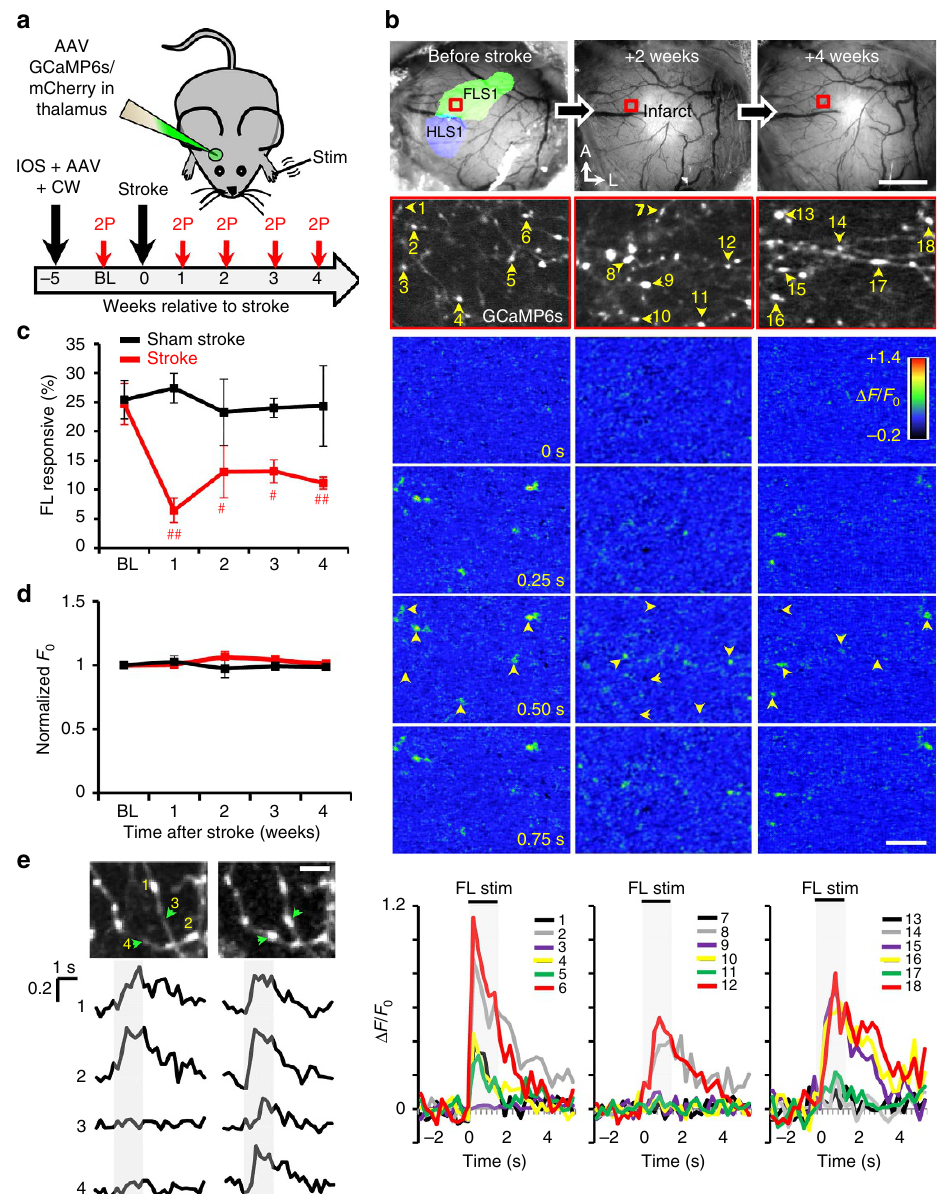
Figure 2 | Thalamocortical axons are less responsive to forelimb stimulation after stroke. ( a ) Graphical summary of GCaMP6s imaging experiments. ( b ) Top, bright-field images of the cortical surface before and after stroke (top row). IOS imaging was used to delineate the functional representation of the FLS1 and primary hindlimb somatosensory cortex. Below; images showing GCaMP6s-expressing thalamocortical boutons (numbered 1–18) within boxed regions. Colour montages below show forelimb-evoked changes in GCaMP6s fluorescence ( D F / F 0 ) for axonal boutons imaged before stroke and 2–4 weeks later. Plots show calcium responses to forelimb stimulation ( D F / F 0 ) within individual boutons at each time point. ( c ) Graph shows the percentage of forelimb responsive thalamocortical boutons plotted as a function of time after stroke (2,825 boutons were analysed in 6 stroke mice) or sham (1,706 boutons analysed in 4 mice) procedure. ( d ) Normalized GCaMP6s fluorescence ( F 0 ) in axonal boutons over time. ( e ) Top, images show mCherry-labelled thalamocortical boutons (numbered 1–4) imaged 1 week apart. Bottom, shows forelimb evoked responses ( D F / F 0 ) within each numbered bouton. Note that newly formed boutons (#3, 4) show detectable forelimb-evoked calcium responses. Data are means ± s.e.m. # P o 0.05; ## P o 0.01 based on t -tests comparing BL to each week of recovery. Scale bars, ( b ) 1mm (top right), 10 m m (bottom right); ( e ) 5 m